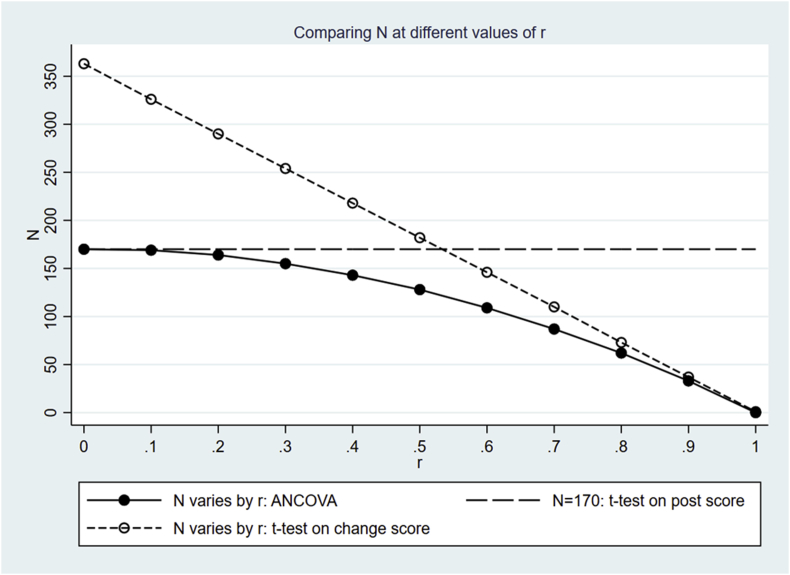
Similar to Fig. 1 above, except that the values of s(Y1−Y0)2 are allowed to vary according to the values of r. Note that the range of the y-axis here is different from that in Fig. 1.